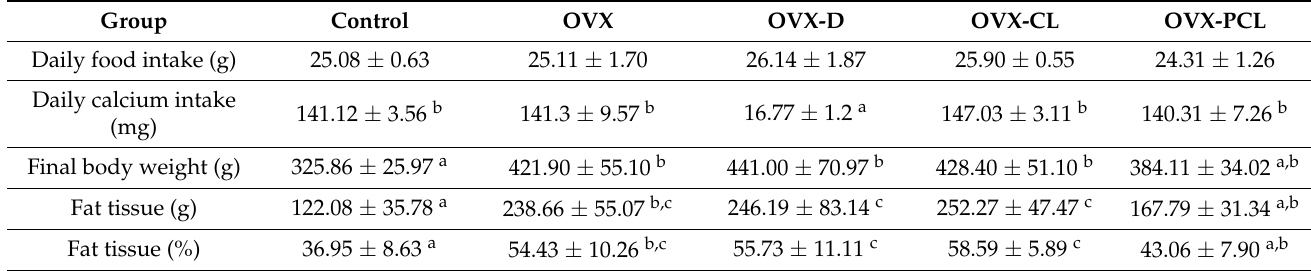
Table 2. Daily intake of the diet, final body weight, and fat content in rats (mean and standard deviation). Group Control OVX